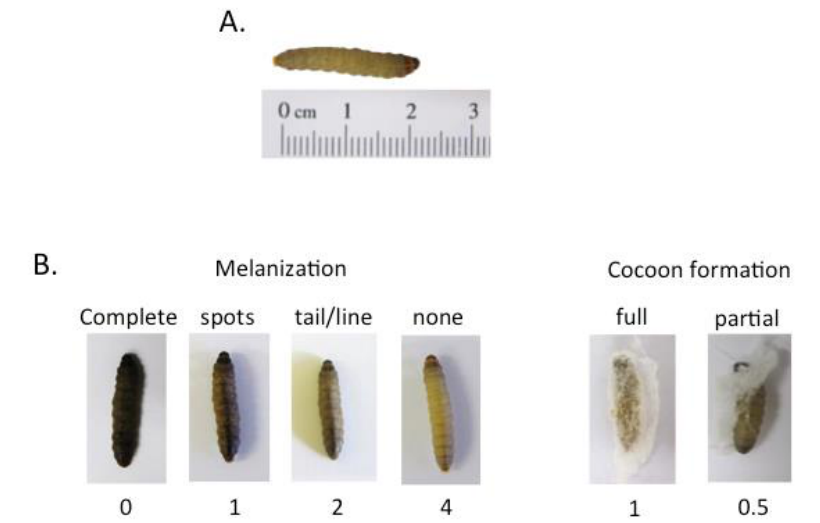
Figure 1. Changes in the appearance of G. mellonella larvae after infection ( B ) compared to healthy final instar stage larvae ( A ). Reproduced from [22] with the permission of the authors. Progressive melanisation of larvae is shown from right (none) to left (complete).